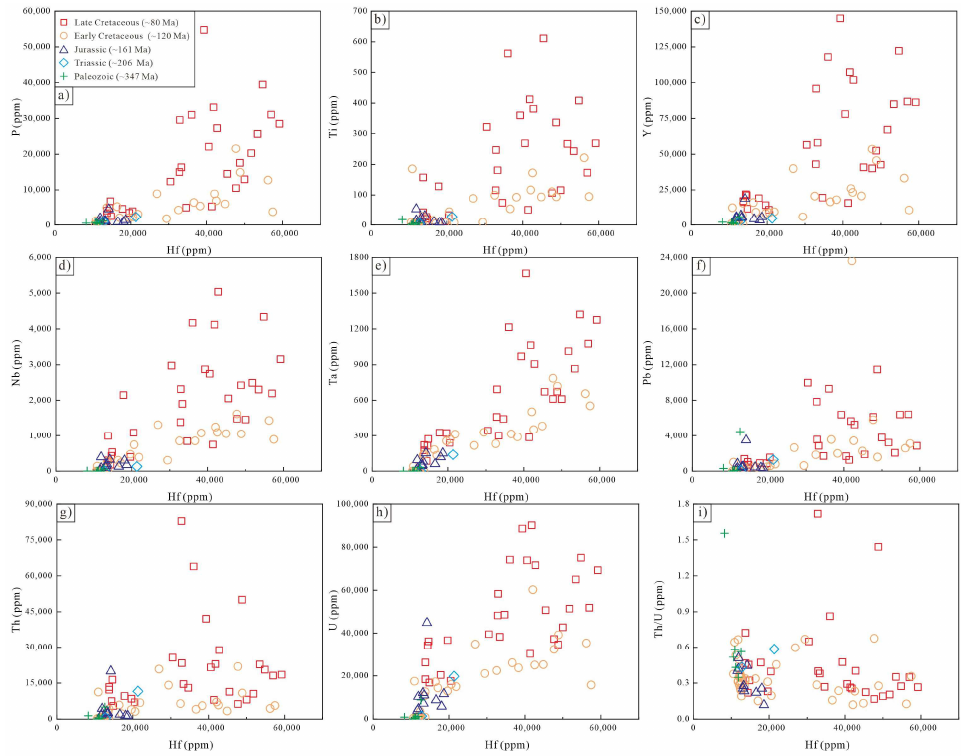
Figure 12. Variation of trace element composition in zircon: Plots of Hf vs. ( a ) P; ( b ) Ti; ( c ) Y; ( d ) Nb; ( e ) Ta; ( f ) Pb; ( g ) Th; ( h ) U; and ( i ) Th/U.